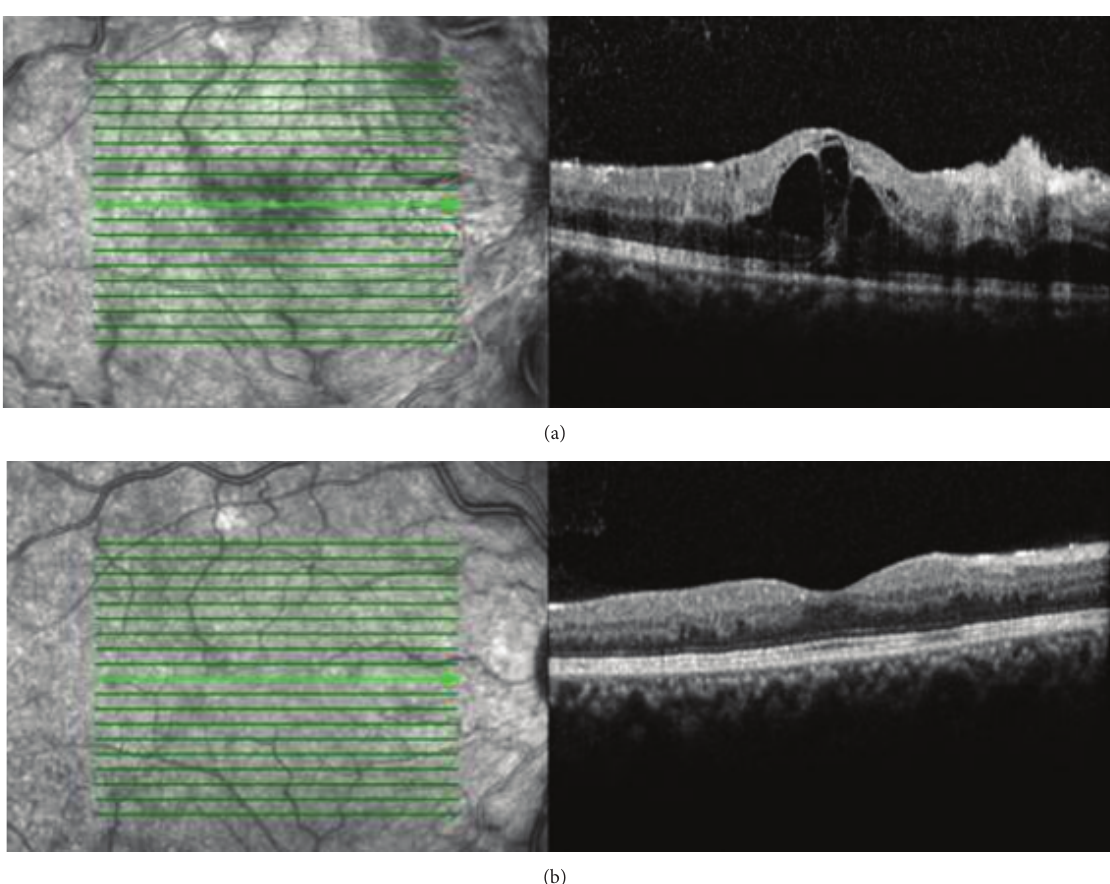
Figure 2: (a) Optical coherence tomography of the left eye shows macular edema (central foveal thickness: 437 𝜇 m). (b) Optical coherence tomography of the left eye after 8 weeks (central foveal thickness: 242 𝜇 m) (after two monthly ranibizumab